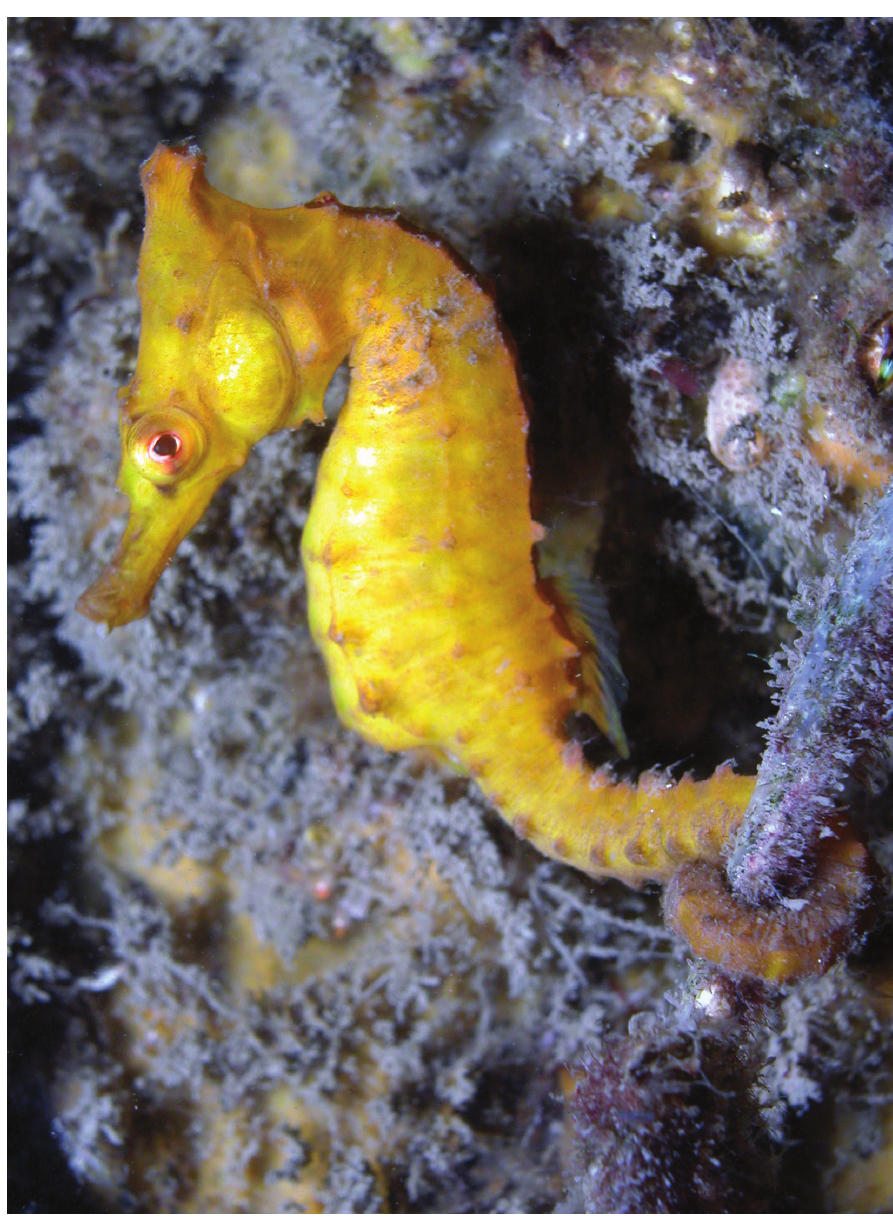
Figure 3. Hippocampus whitei in situ, adult female, Nelson Bay, NSW, Australia at 5 m depth (photo- graph David